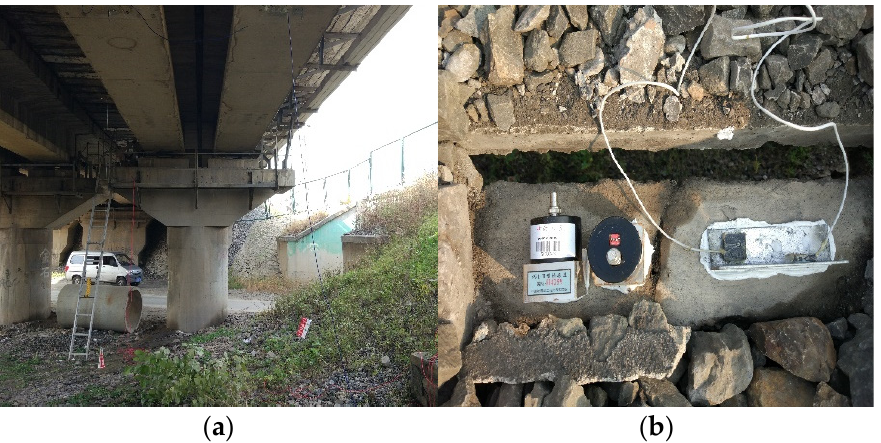
Figure 17. The layout of the field test sensors: ( a ) The layout of displacement sensors; ( b ) The layout of acceleration sensors.